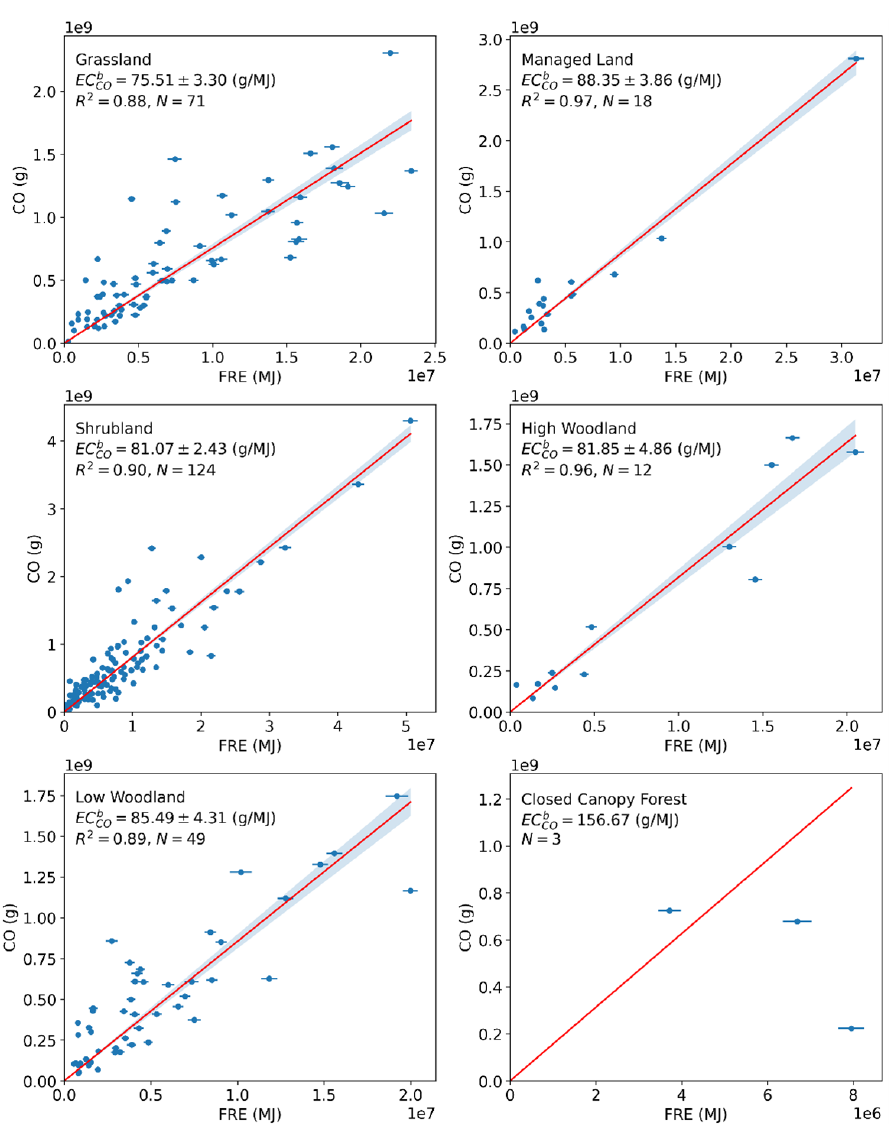
; in gMJ − 1 ) derived from match-up fires burning across the six fire-affected Figure 2. Carbon monoxide smoke emission coefficients (EC b CO biomes shown mapped in Fig. 8b across Southern Hemisphere Africa (note that the match-up fires here come from both African hemispheres). Each EC b is derived from the slope of an ordinary least-squares (OLS) regression between the fire-emitted CO calculated from Sentinel- CO 5P total column CO (TCCO) observations and the fire’s matching FRE. The shaded grey area indicates the error of each slope. Error bars represent the uncertainty in both the FRE and total plume CO calculated from the uncertainty measures of the FRP-PIXEL product and the S5P TCCO product respectively. Closed-canopy forest had insufficient match-up fires identified, and so EC b for this biome was derived CO using the FEER-equivalent procedure detailed in Sect. 2.3 and in Nguyen and Wooster (2020). Data points from the three match-up fires that were identified in closed-canopy forest are included in the